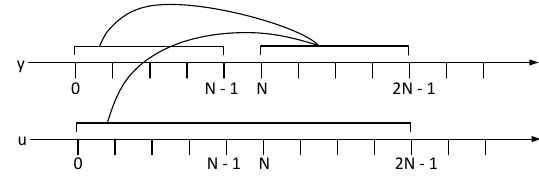
Figure 3. Output predictions (N = 5).